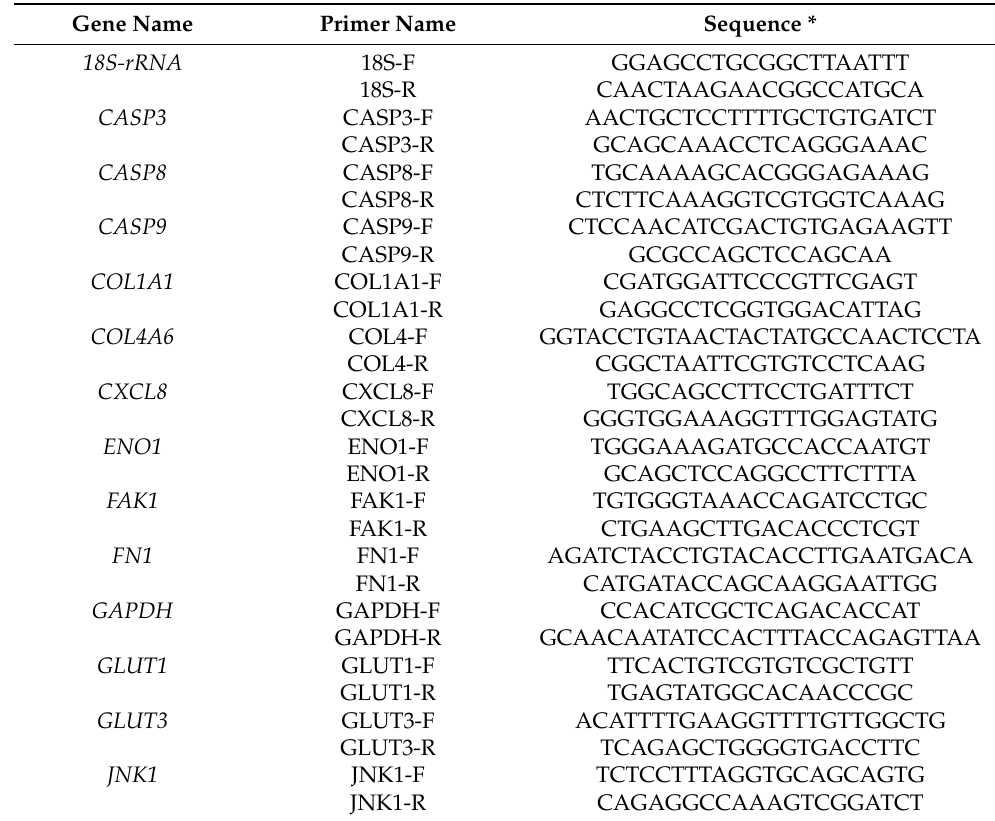
Table A2. Overview of the primers used for qPCR